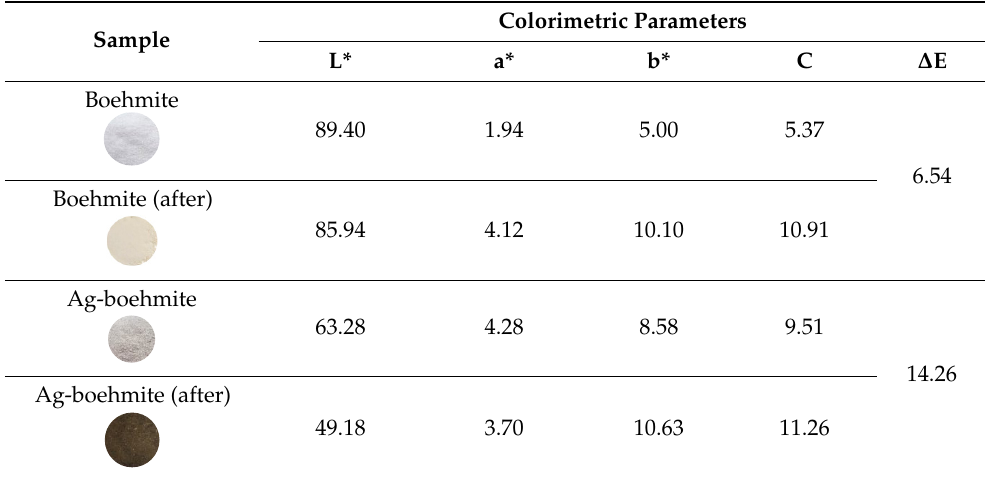
Table 6. Colorimetric parameters of samples before and after water treatment.